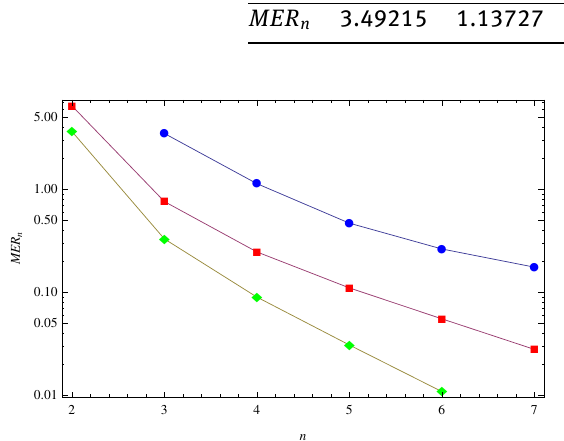
Figure 13: Comparison of the logarithmic plots of MER n with equal- length subintervals: circle dot for the 2-stage ADM, square dot for the 3-stage ADM, and diamond dot for 4-stage ADM.